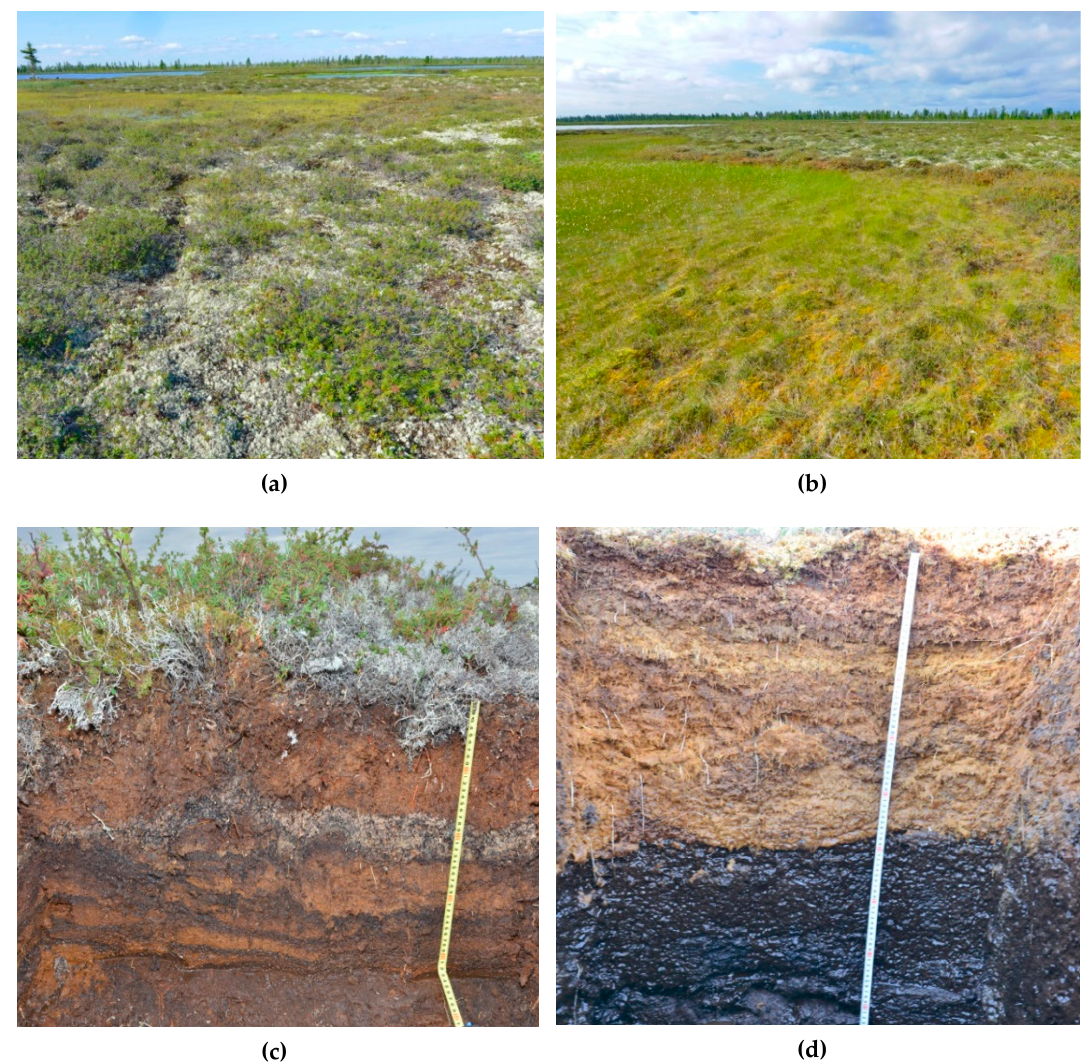
Figure 3. Plant communities and soils of the frozen bogs of the Khanymey site: ( a ) Moss–shrub–lichen community on the mound; (b) moss–sedge community of lakeside fen; ( c ) Dystric Hemic Epicryic Histosols; ( d ) Dystric Epifibric Endohemic Histosols. The soil of ( c ) correspond to the plant community of ( a ), and the soil of ( d ) correspond to ( b ).